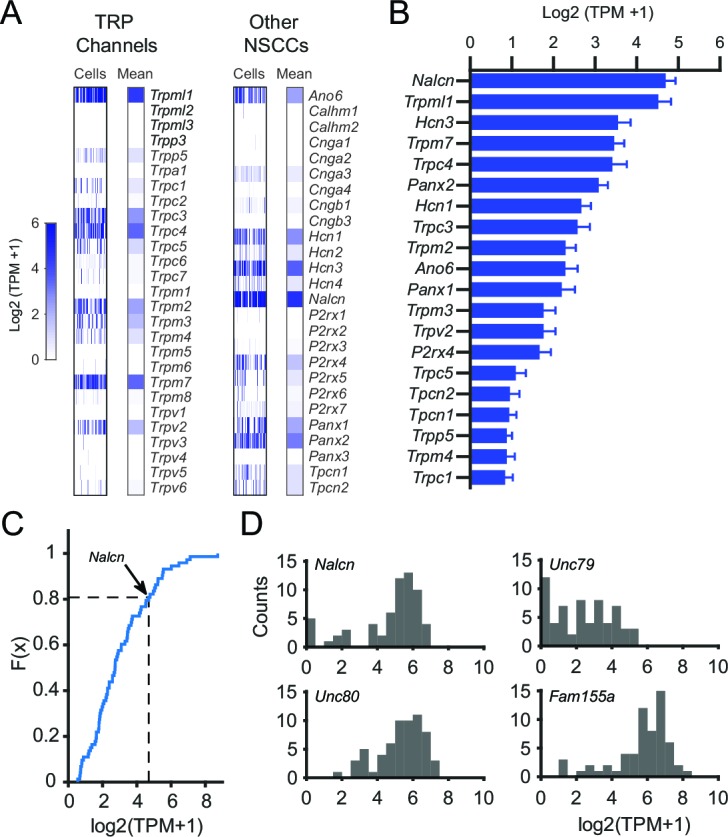
Gene expression results for NSCCs in SNr neurons.(A) Relative gene expression levels of TRP channels (left) and other NSCCs (right) in individual SNr neurons and the population average. (B) Bar graph of the mean log2 (TPM +1) for the top 20 NSCCs in descending order. Error bars indicate s.e.m. (C) Cumulative distribution plot of the mean expression level of all ion channels that were consistently expressed by SNr neurons (73 out of 232 total ion channel genes). The average level of expression of Nalcn is indicate by arrow and dashed line. (D) Histograms of expression of Nalcn, Unc79, Unc80, and Fam155a in SNr neurons.